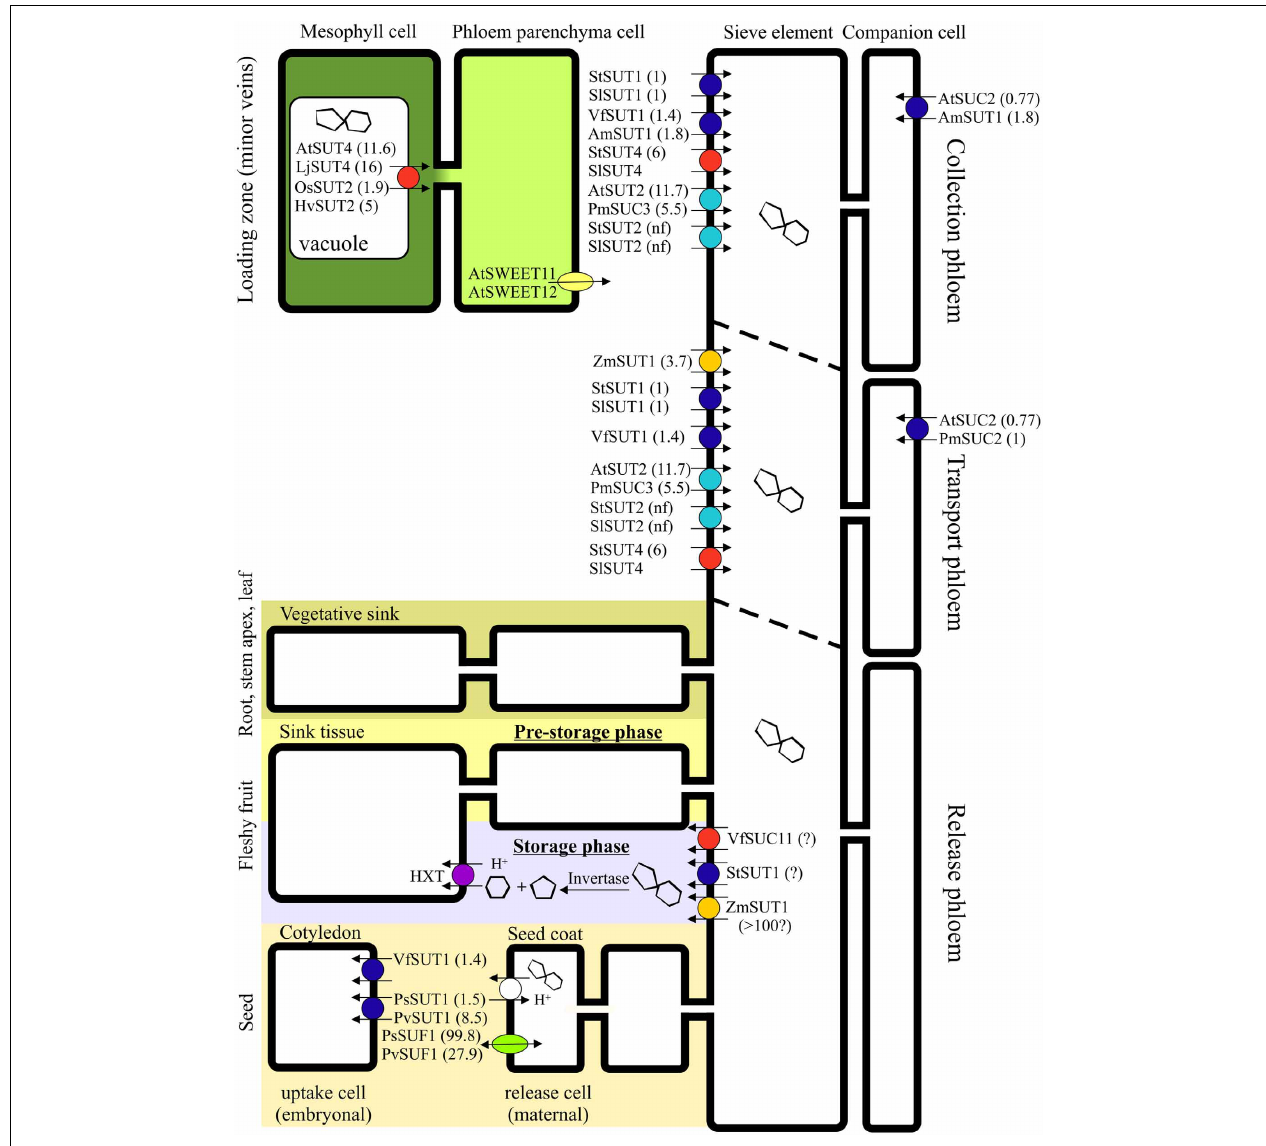
FIGURE 3 | Schematic presentation of the affinity constants of sucrose transporters involved in apoplasmic phloem loading, transport, and unloading. K m values were taken from (Riesmeier et al., 1993; Weber et al., 1997; Barker et al., 2000; Schulze et al., 2000; Weise et al., 2000; Weschke et al., 2000; Manning et al., 2001; Reinders et al., 2002; Barth et al., 2003; Knop et al., 2004; Carpaneto et al., 2005; Zhou et al., 2007; Eom et al., 2011; Gould et al., 2012). Sucrose transporters are indispensible for apoplasmic phloem loading, but play a rather marginal part in symplasmic phloem loading as it occurs in numerous species. In transport phloem, sucrose transporters are prominent under the usually prevailing source-limiting conditions, whereas their role is reduced under sink-limiting conditions. While phloem unloading in terminal leaf and root sinks occurs entirely symplasmically, the unloading path in larger sinks may include an apoplasmic step. Due to the obligatory symplasmic isolation of the embryo from the maternal seed-coat tissue in Pisum sativum and Phaseolus vulgaris , an apoplasmic loading step is required involving sucrose transporters and facilitators (Patrick, 2013). A sucrose/proton antiport mechanism of unknown identity was postulated in seed coats of Vicia faba (Fieuw and Patrick, 1993) and Phaseolus vulgaris (Walker et al., 1995). PsSUT1 was also localized in the vascular tissue of the